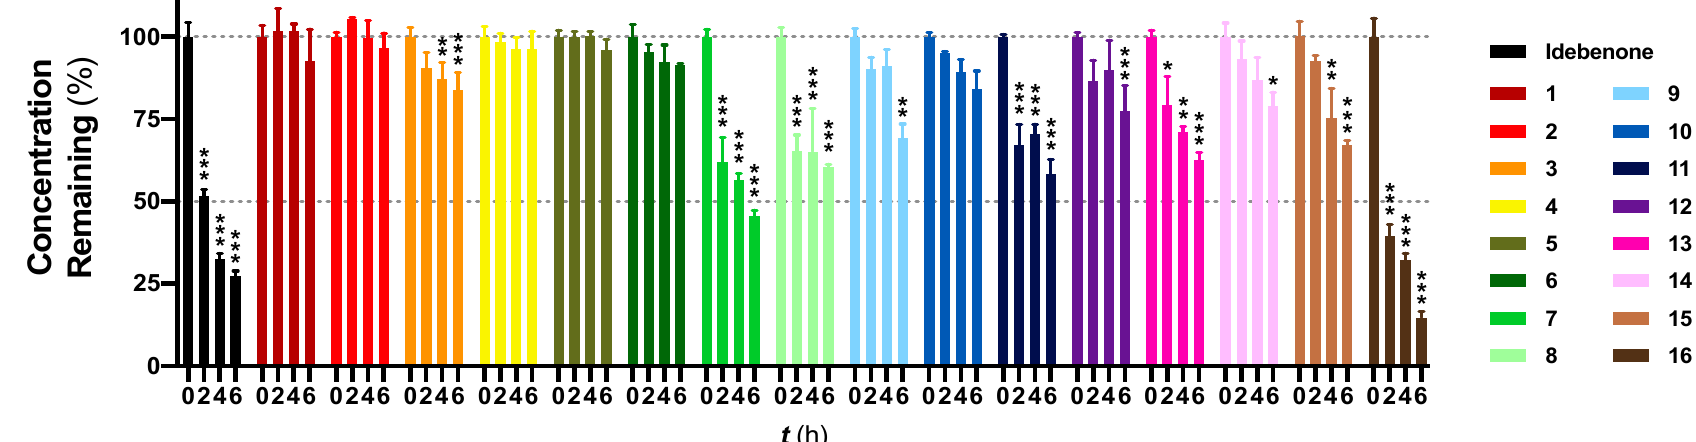
Figure 1. Metabolic stability study of 16 new SCQs and the reference benzoquinone idebenone. HepG2 cells were exposed to each SCQ at 40 µ M for up to 6 h. Concentrations found at t = 0 were normalized to 100% and concentrations found at other time points were normalized by accordingly dividing by the concentrations found at t = 0, × 100%. Data was expressed as mean ± standard error of mean (SEM) from at least one experiment, with at least three data points each. Two-way ANOVA was performed to compare concentrations found at t = 2 h, 4 h, 6 h to t = 0 for each compound: *** p < 0.001, ** p < 0.002, * p < 0.033.